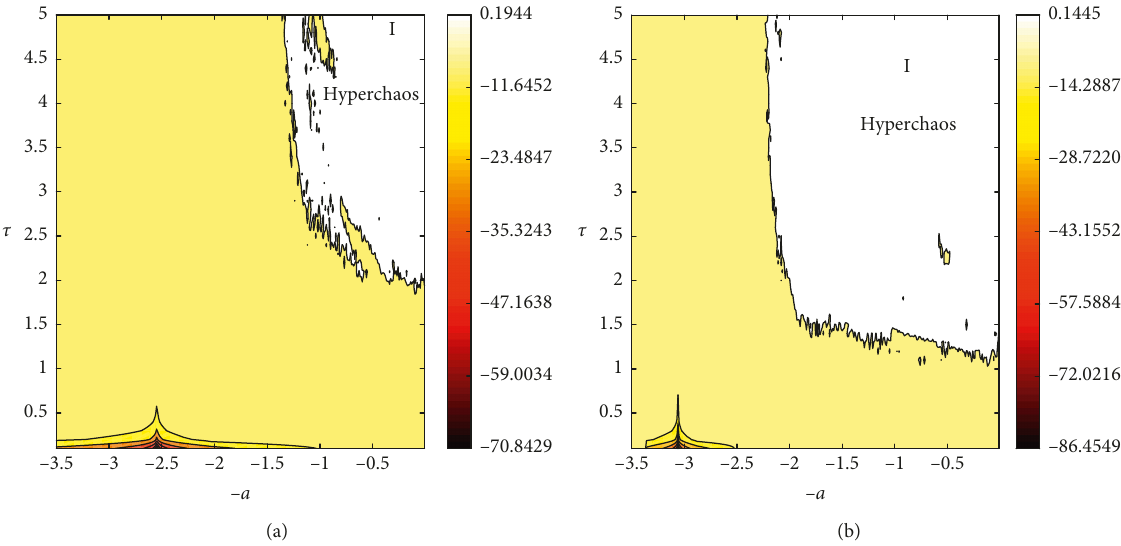
Figure 12: (a) The 2D LE diagram showing the second largest Lyapunov exponent ( λ 2D LE diagram showing the second largest Lyapunov exponent of the ACCM-Ikeda TD system in the ( a − τ ) space. 0.511.522.533.544.55